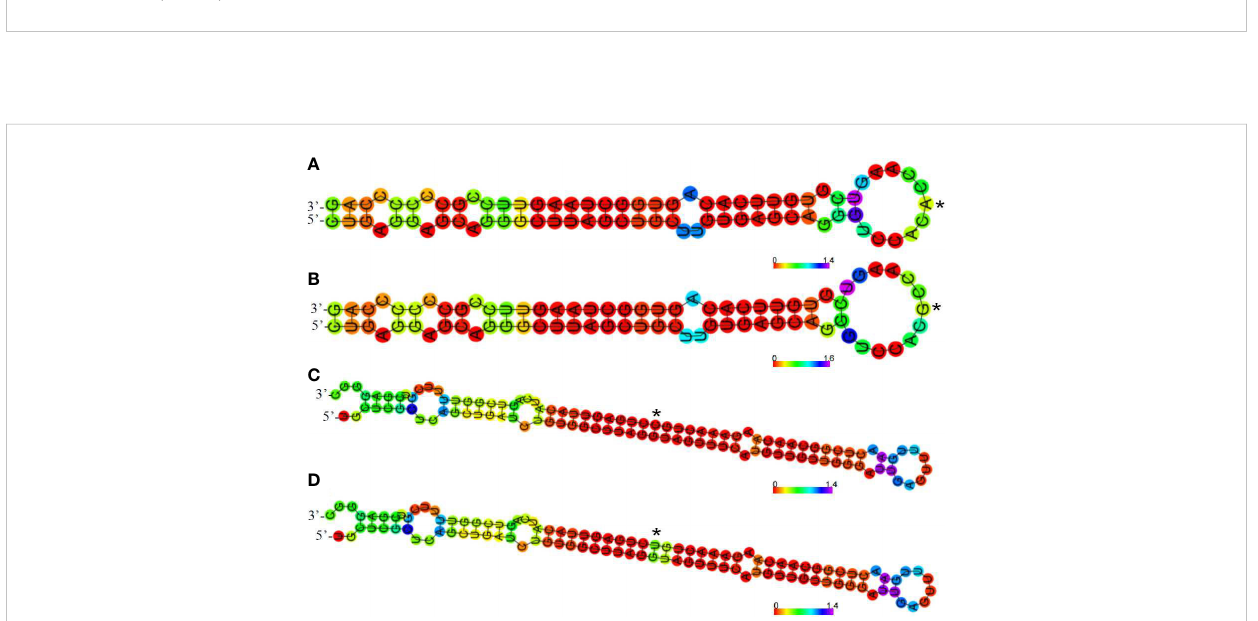
FIGURE 2 Centroid secondary structure of pre-mir-27a and pre-mir-196a2. The size of the miRNA hairpin loop increases when the rs895819 T allele is replaced by the C allele. (A) hsa-miR-27a (reference), (B) hsa-miR-27a (mutant), (C) hsa-miR-196a2 (reference), (D) hsa-miR-196a2